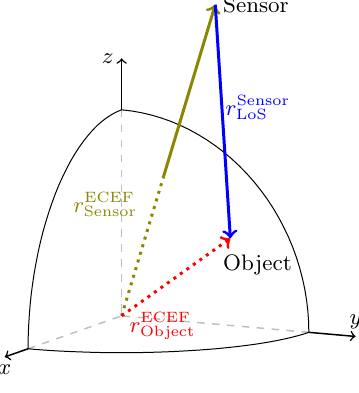
Figure 4: The used sensor